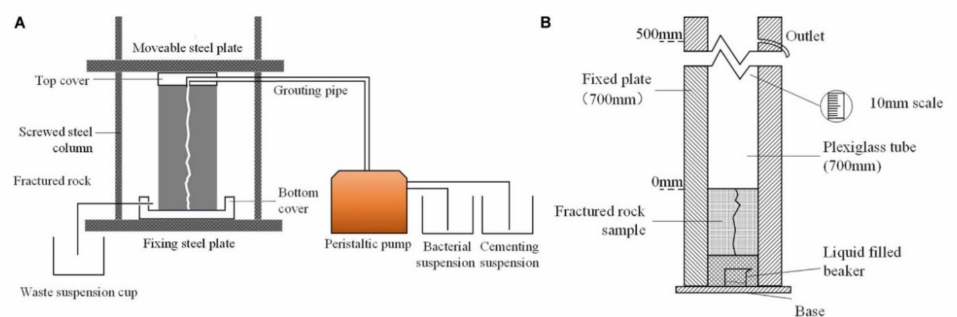
Figure 4. Schematic diagram of MICP experimental device. ( A ) Grouting device; ( B ) Seepage device [11].